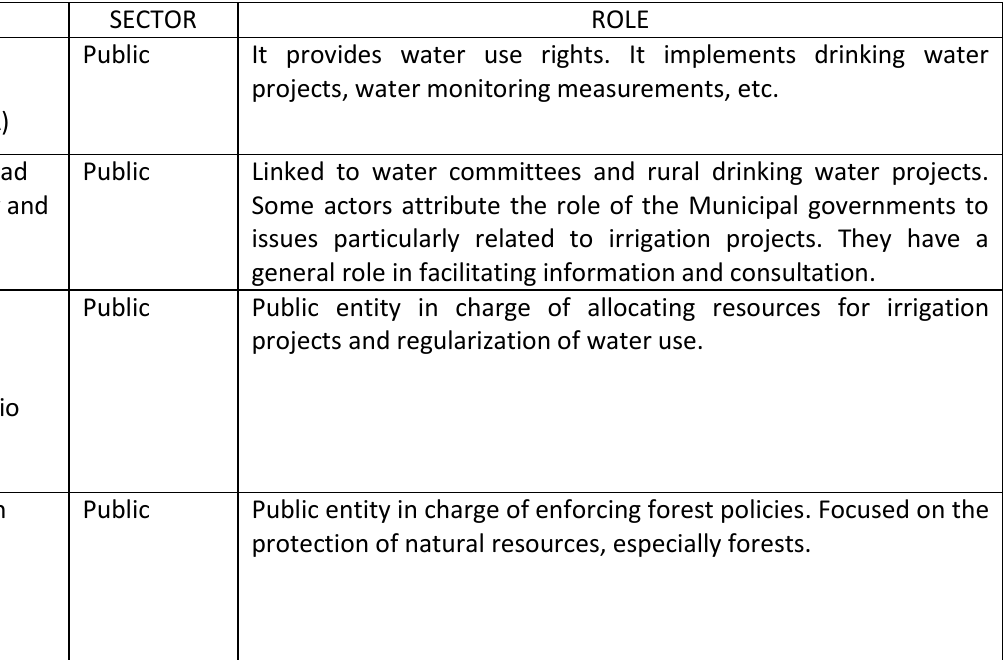
Table A3.2. Main actors and perceived roles in the water governance network of the